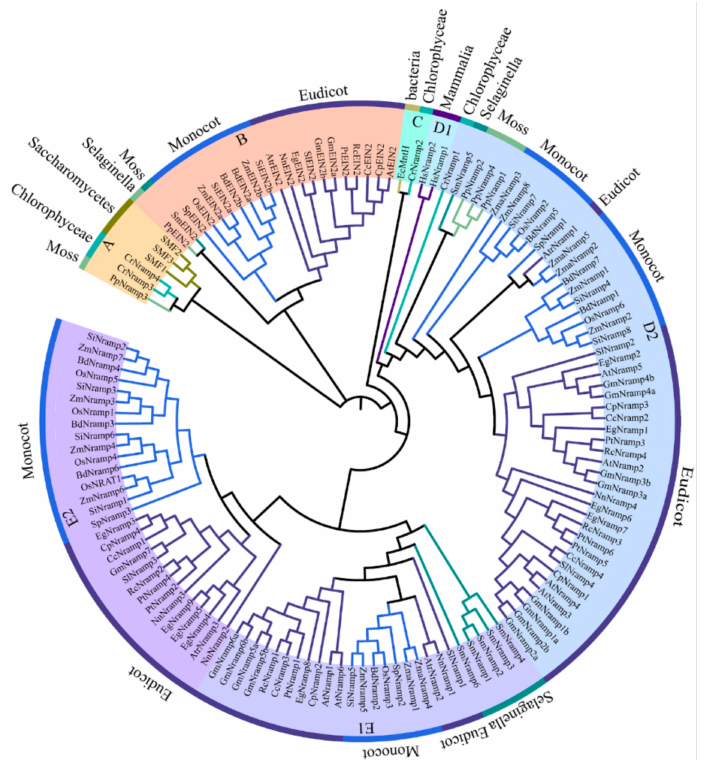
Figure 1. Phylogenetic analysis of 138 Nramp proteins in S. polyrhiza and 22 other species. The maximum likelihood tree was constructed using MEGA X (bootstrap value = 1000) based on the JTT matrix-based model. Various colored circles represent the different groups. Four Nramp genes, namely SpNramp1 , SpNramp2 , SpNramp3 , and SpEIN2 , were identi- fied in S. polyrhiza . Among these genes, the SpNramp genes carried the consensus residues GQSSTITGTYAGQF(/Y)I(/V)MQ(/G)GFLN(/D) (Table 1), a unique structural feature in a Nramp metal transporter family